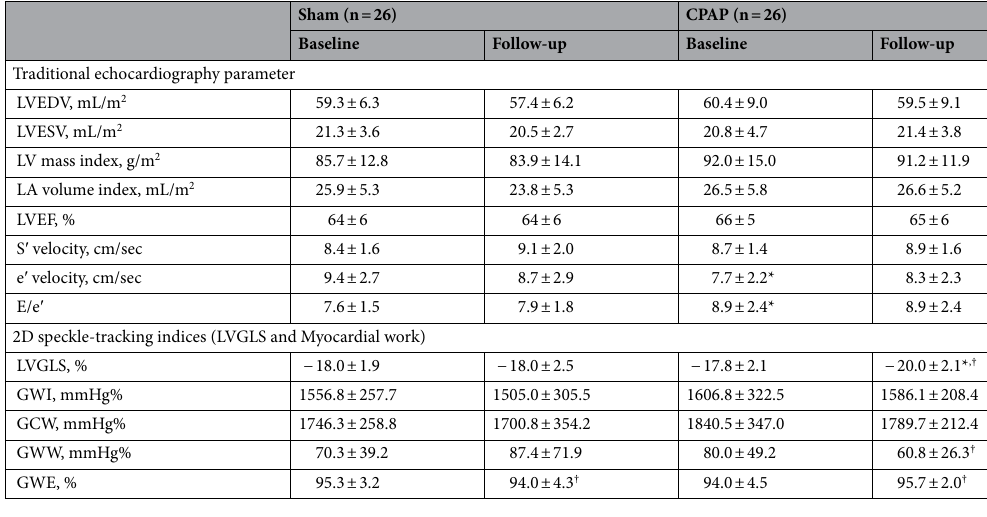
Table 3. Echocardiographic parameters of the study population. *Student’s t-test, p < 0.05, compared with the corresponding sham group. † Paired t-test, p < 0.05, compared to baseline values within the group. GCW global